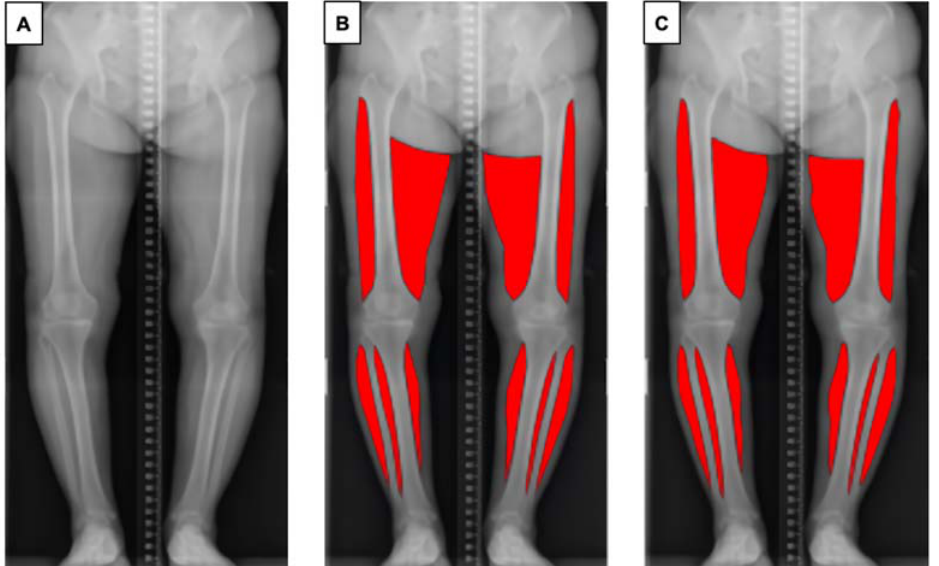
Figure 1. Overview of the pipeline for automatic muscle segmentation of full-leg plain radiographs. ( A ) Original radiographic image. ( B ) Ground truth mask of segmented muscle generated by the authors. ( C ) Segmented muscle predicted by the proposed model.